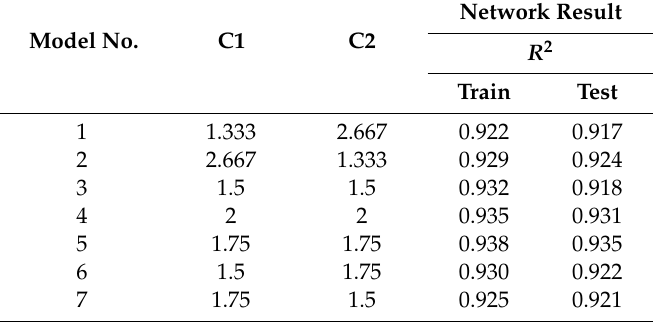
Table 3. Testing the di ff erent values of C1 and C2 with their R 2